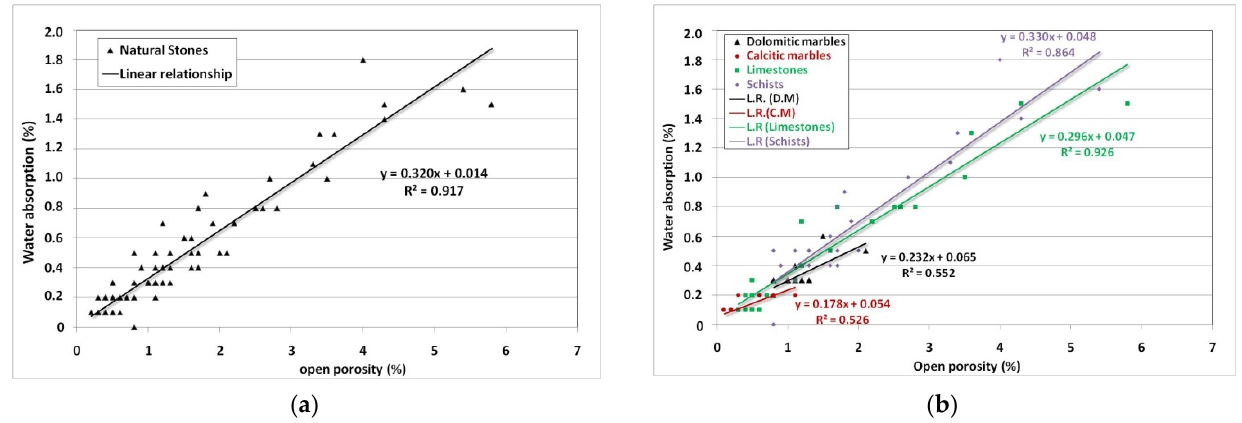
Figure 6. ( a )Overall correlation between WA and OP. ( b ) Correlation equations between open porosity and water absorption.